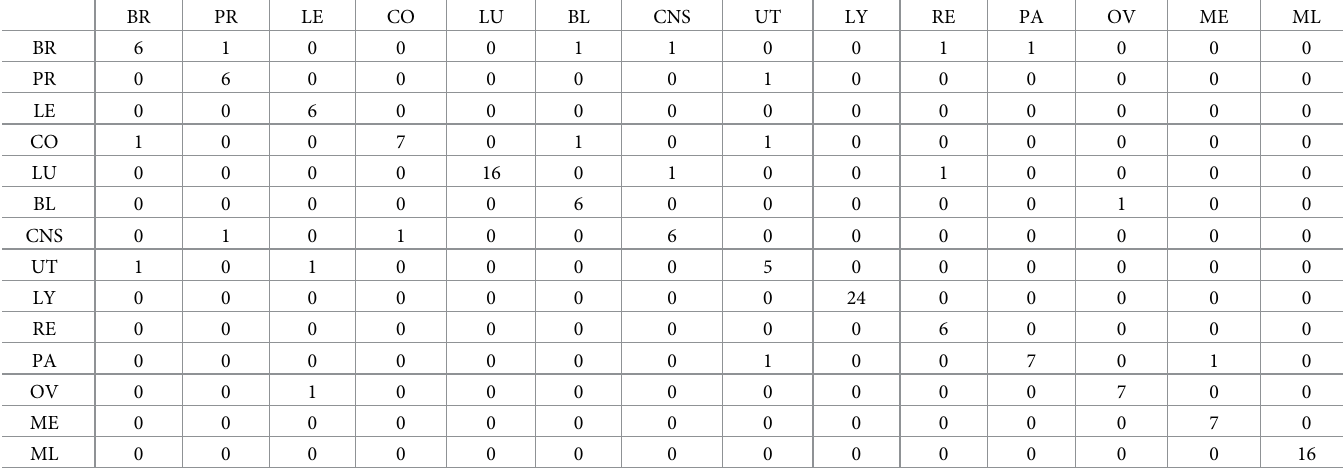
Table 2. A 14 × 14 confusion matrix: Model fittness based on the MLR-HomoNet method for the training data T .